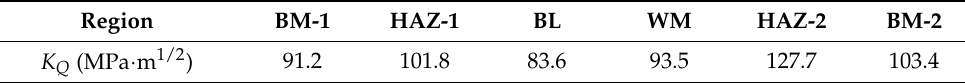
Table 3. The K Q values in different regions of the DMWJ.